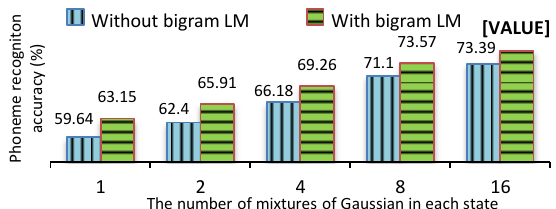
Figure 8. Phoneme recognition accuracy using GMM- HMM baseline